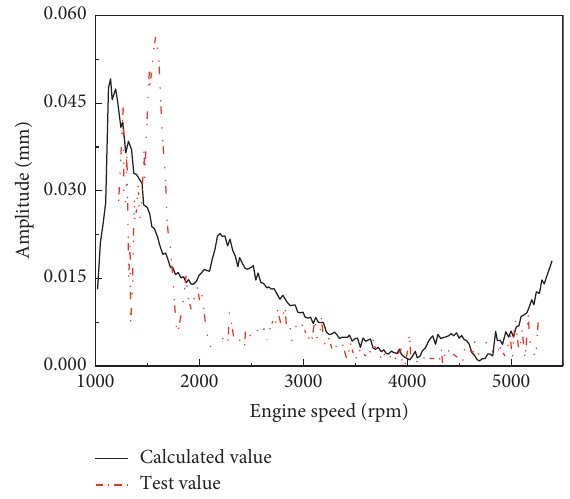
Figure 10: The calculated and measured 2nd-order displacement amplitude of the torque strut.